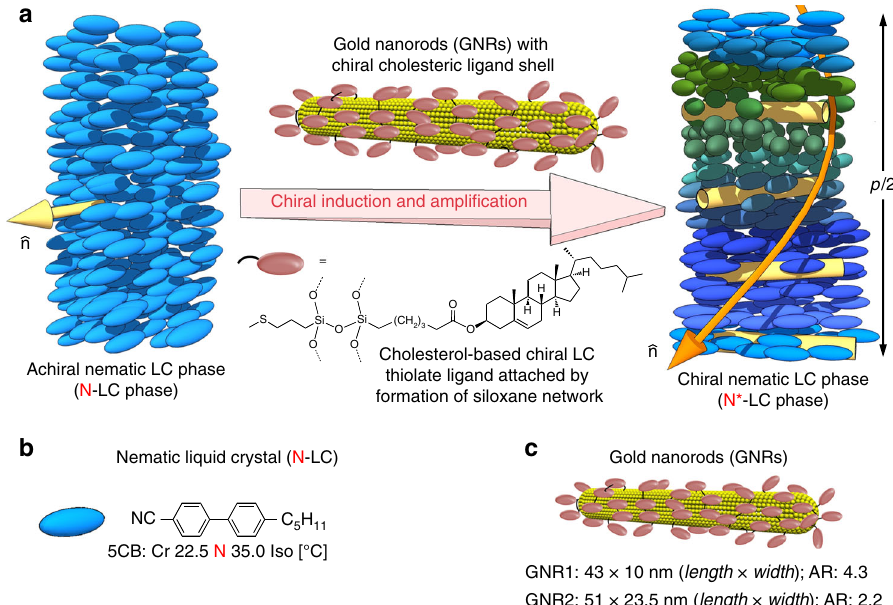
Fig. 1 Materials and approach to testing chiral ampli fi cation. a Schematic representations of the N*-LC phase induced by addition of minute amounts of chiral cholesterol-capped GNRs into an achiral N-LC host. b The N-LC host 5CB. c Depiction of and values for length, width, and aspect ratio (AR) for GNR1 and